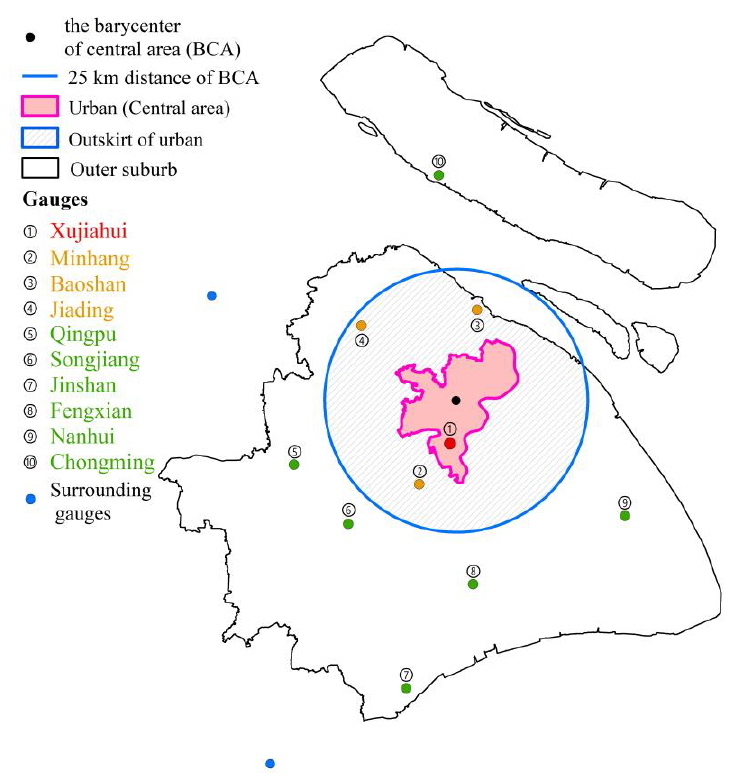
Figure 3. Location of the selected 10 rain gauges in Shanghai and the two surrounding rain gauges.